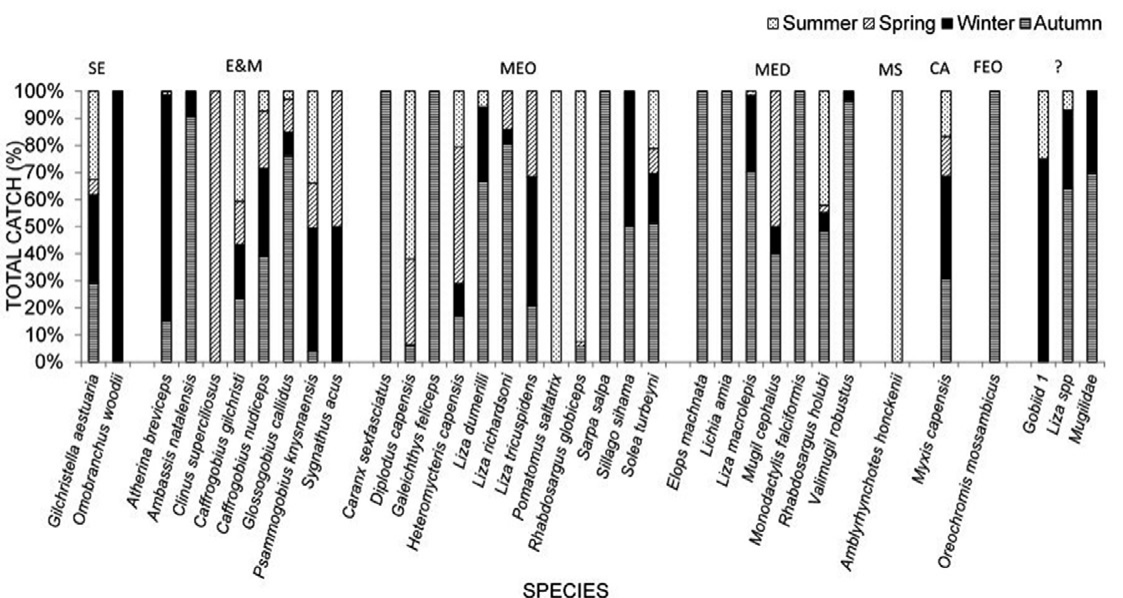
Fig. 2. – Percentage contribution of each season to total catch by the large-mesh seine net for each species grouped by estuarine association (Potter et al. 2015) in the Swartkops Estuary (February 2013 - January 2014). SE, solely estuarine species; E&M, estuarine and marine species; MEO, marine migrant estuarine opportunists; MED, marine migrant estuarine dependent: MS, marine stragglers; CA, catadromous; FEO, freshwater estuarine opportunists; ?, unknown.